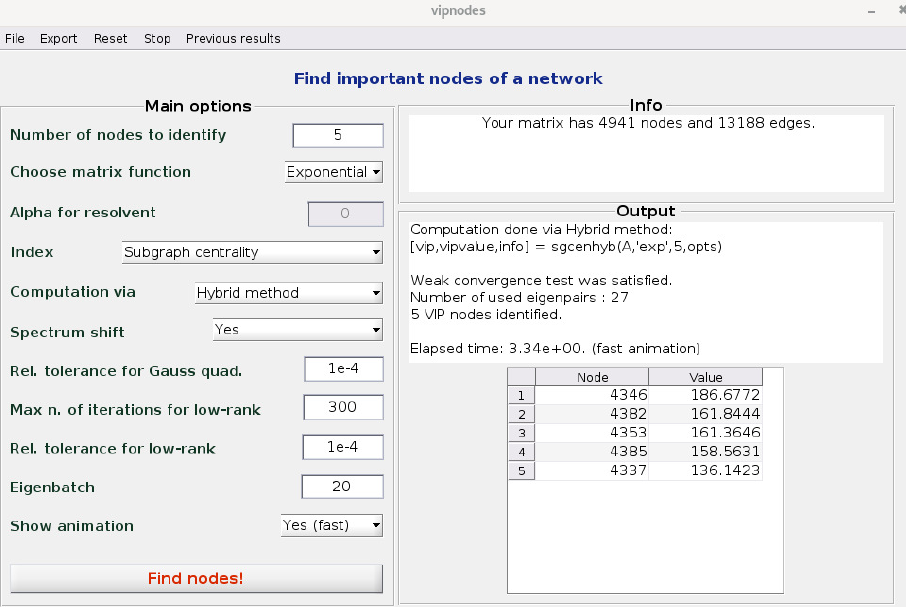
Figure 5. Main window after the identification of the five most important nodes for the Power network by the hybrid